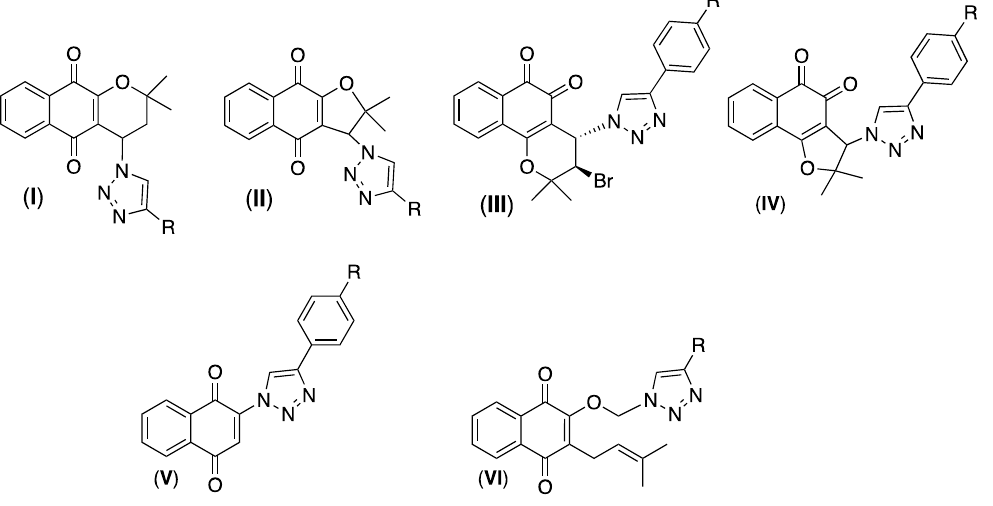
Figure 1. Structures of antiparasitic naphtoquinone triazoles.